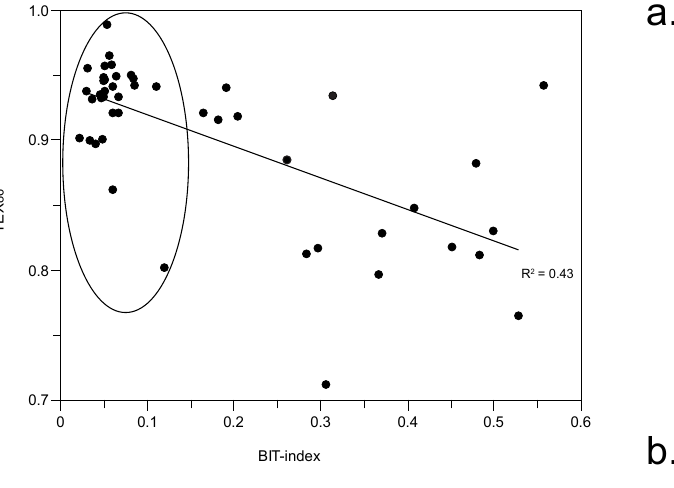
Figure 4. Cross plot of TEX 86 against BIT index values.